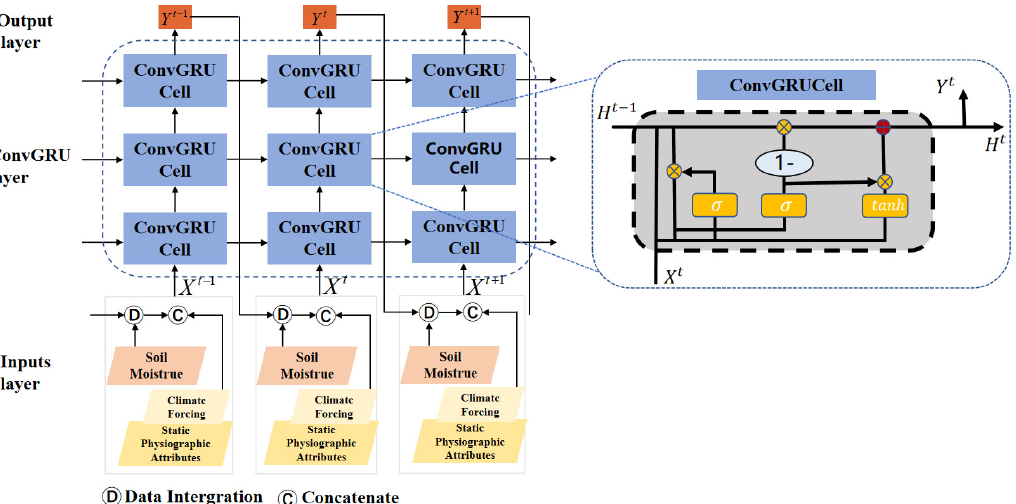
Figure 2. The network structure of DI_ConvGRU. X is the input, H is the hidden layer, and Y is the output.